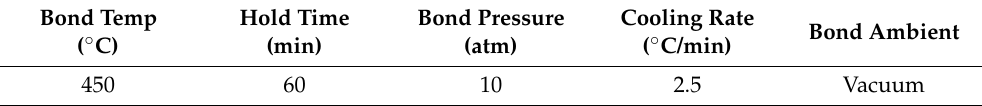
Figure 2. The thermal profile of glass frit bonding: ① After screen printing; ② Removal of the organic solvent; ③ Removal of the organic binder; ④ Optimized alternating three-step annealing process; ⑤ , ⑦ Bonding; ⑥ initial pre-sintering (purely in air). Table 2. Bonding